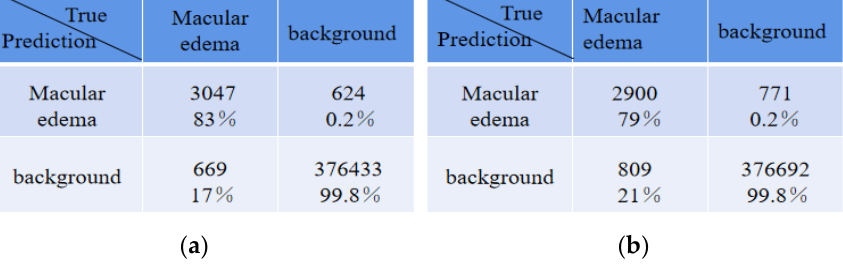
Figure 14. Comparison of confusion matrices. ( a ) the proposed method; ( b ) ReLayNet.